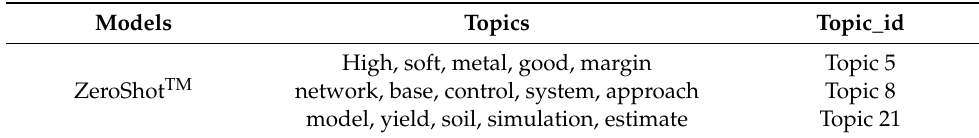
Table 6. Partial example of the model at K = 50 topic number.